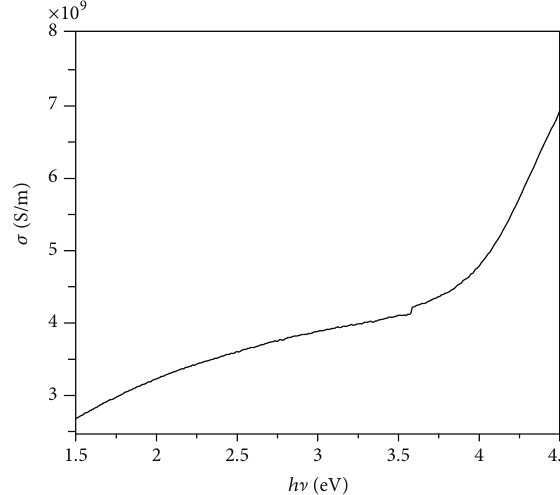
Figure 9: Variation of optical conductivity 𝜎 with photon energy.